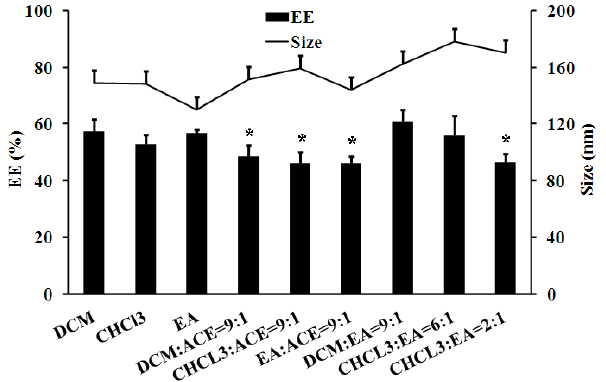
Sal-LPNPs (mean ± SD, n = 3). * indicated there was significant difference ( p < 0.05) compared to DCM:EA = 9:1 group. DCM: dichloromethane; CHCl acetate; ACE: